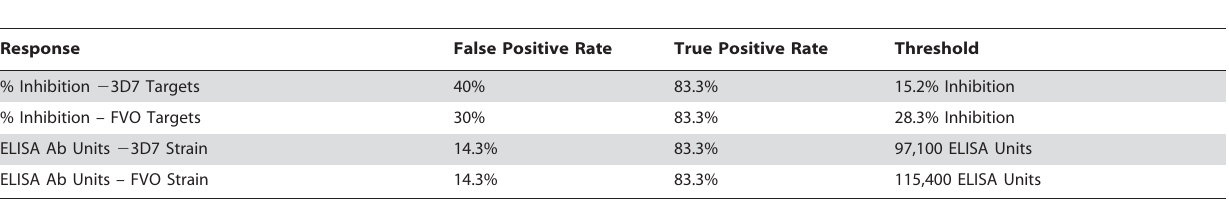
Table 6. Results from ROC graphs for Predicting noTx by Using GIA or ELISA with Ag Expressed in Baculovirus